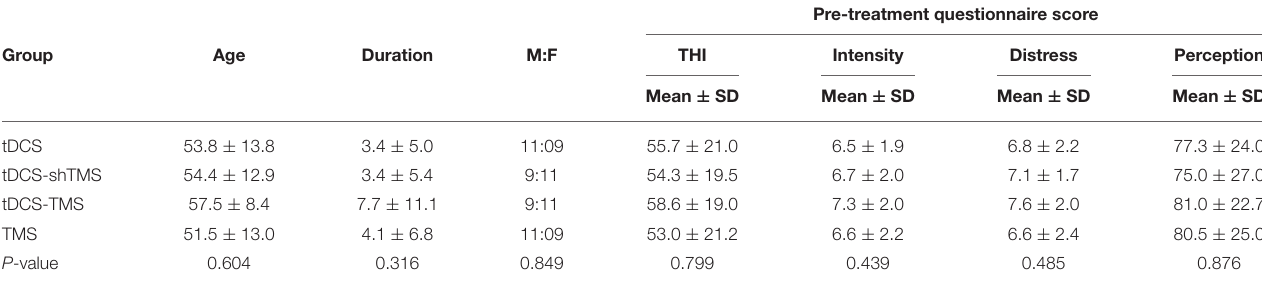
TABLE 1 | Demographic characteristics of the study subjects in all four